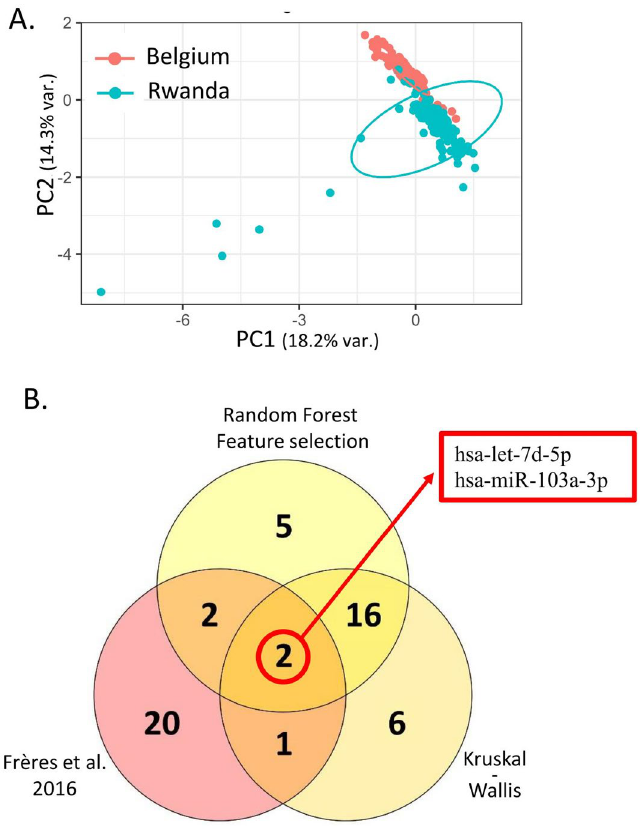
Figure 3. Circulating microRNA contents are different in Belgian- and Rwandan-recruited populations. ( A ) Principal Component Analysis performed on the plasmatic microRNAs from cohorts MATCHED-BE (red) and MATCHED-RW (blue) shows that the two populations display distinct profiles. ( B ) The best 25 circulating microRNAs able to discriminate Belgium-from Rwanda-recruited women were determined either by random forest feature selection or by Kruskal–Wallis statistical test and are represented in the two yellow sets. The 25 circulating microRNAs that were best performing to discriminate healthy women from breast cancer patients in a Belgian-recruited population as determined in the publication Frères et al . are represented in the pink set. The Venn diagram is showing the intersection of these three groups, highlighting hsa-let-7d-5p and hsa-miR- 103a-3p that are able to both discriminate healthy/cancer and Rwanda/Belgium